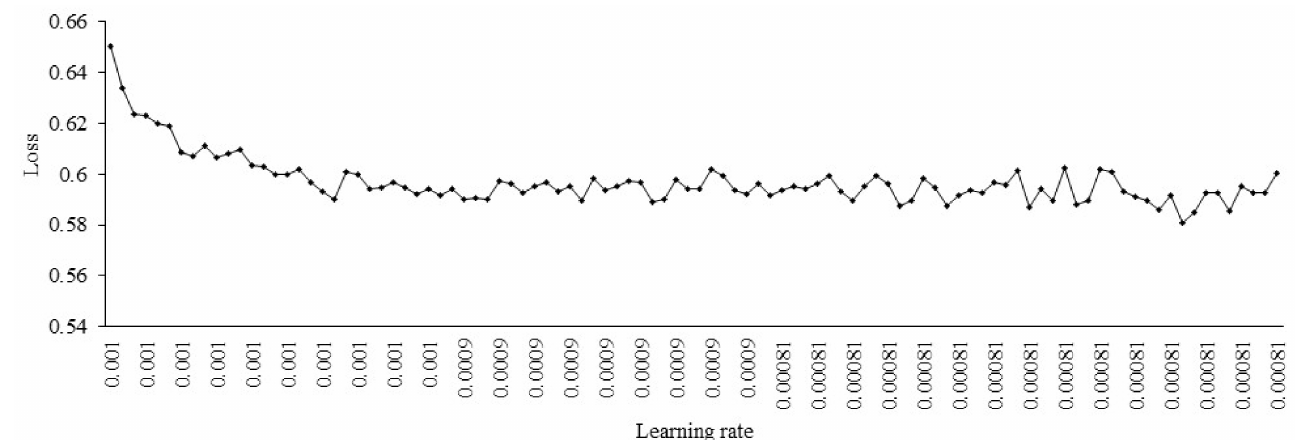
Figure 5. The curve of the learning rate against the loss rate.